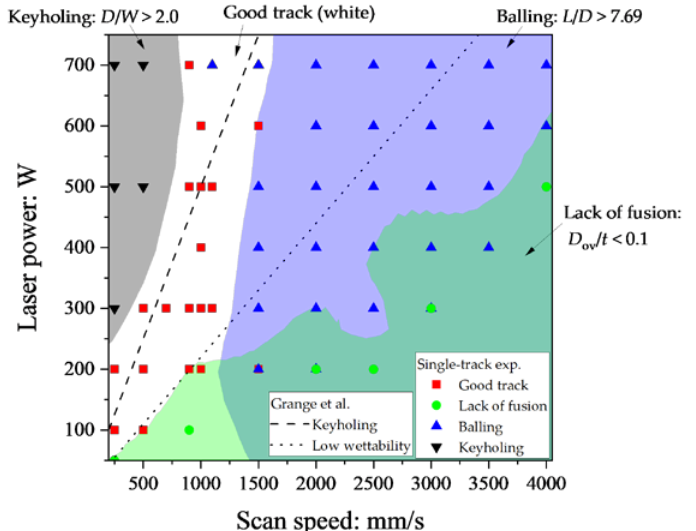
Figure 13. The process window of Inconel738LC using the criteria D / W > 2.0, L / D > 7.69, and D ov / t < 0.1.